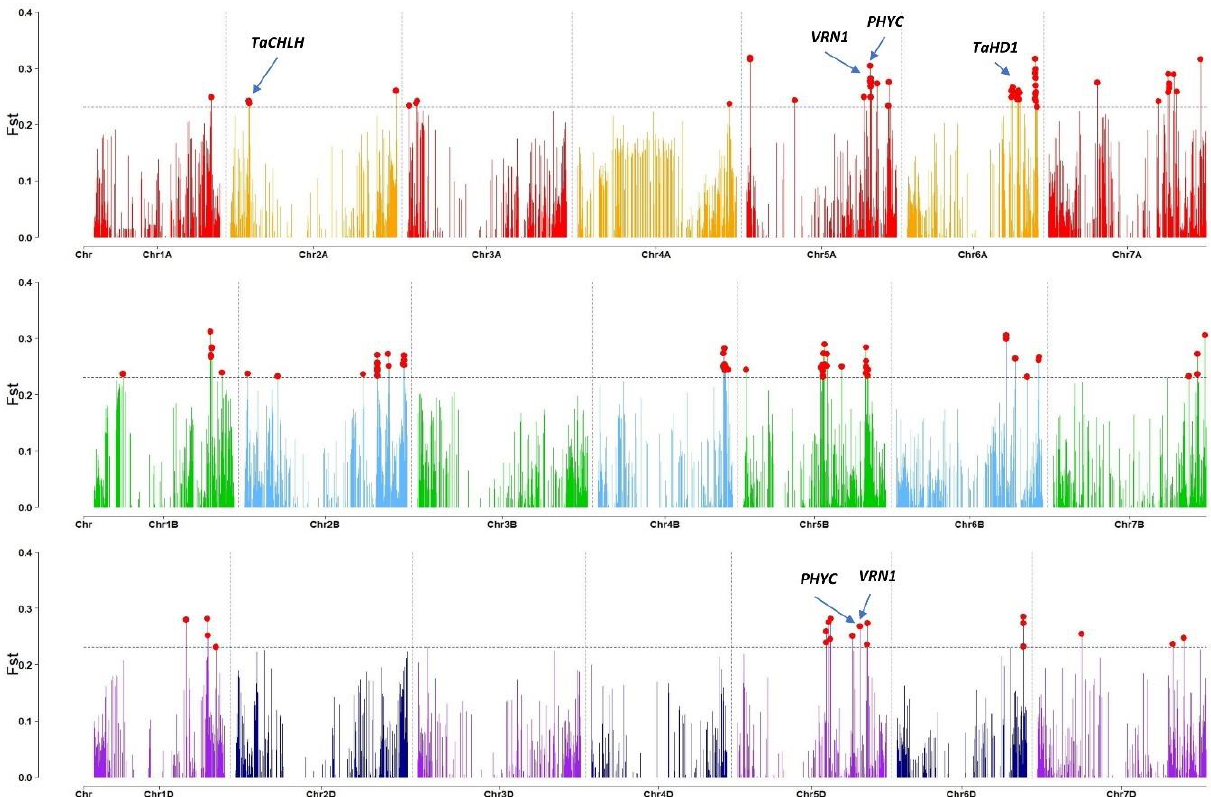
Figure 7. Rectangular Manhattan plot of F st distribution calculated between the red/blue clusters. The dashed horizontal lines indicate the 99 percentiles of F st values. F st values in the highest 1% of the distribution are indicated by red dots and key genes overlapping with extreme F st are labelled.